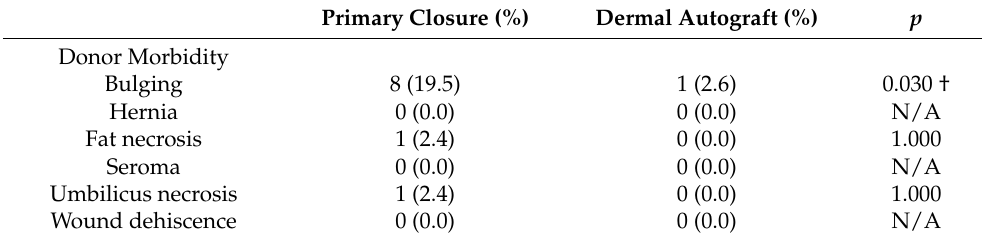
Table 3. Donor-site